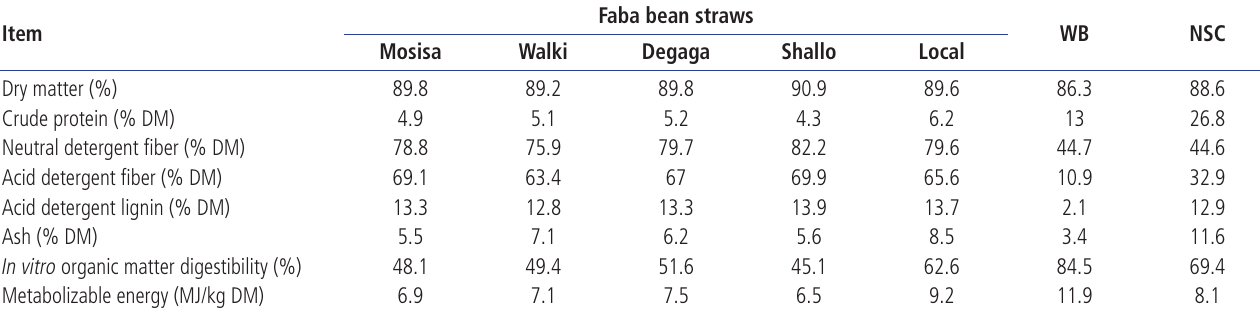
Table 2. Chemical composition, in vitro digestibility and energetic value of main ingredients of the experimental diet Item